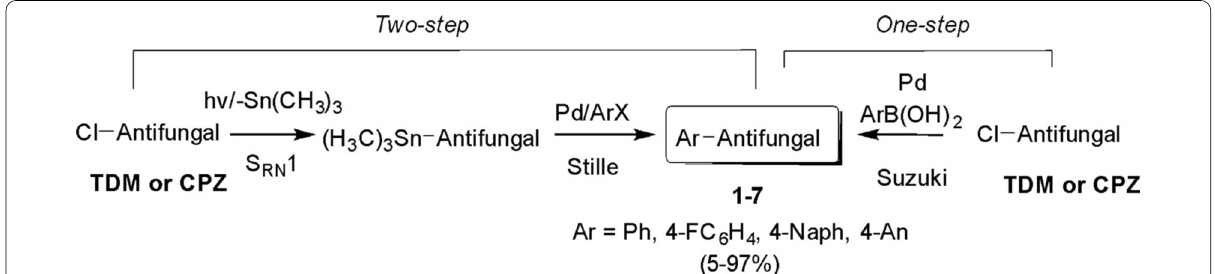
Scheme 1 Methodologies employed for the arylation of TDM and